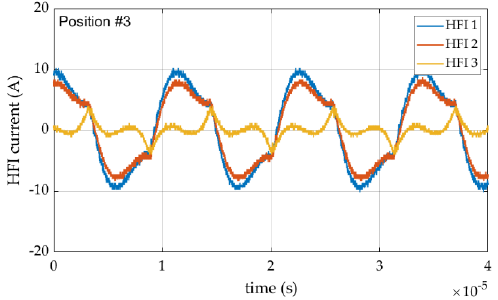
Figure 19. HFIs output currents with partial coupling with the first and the second track coils (Position #3).